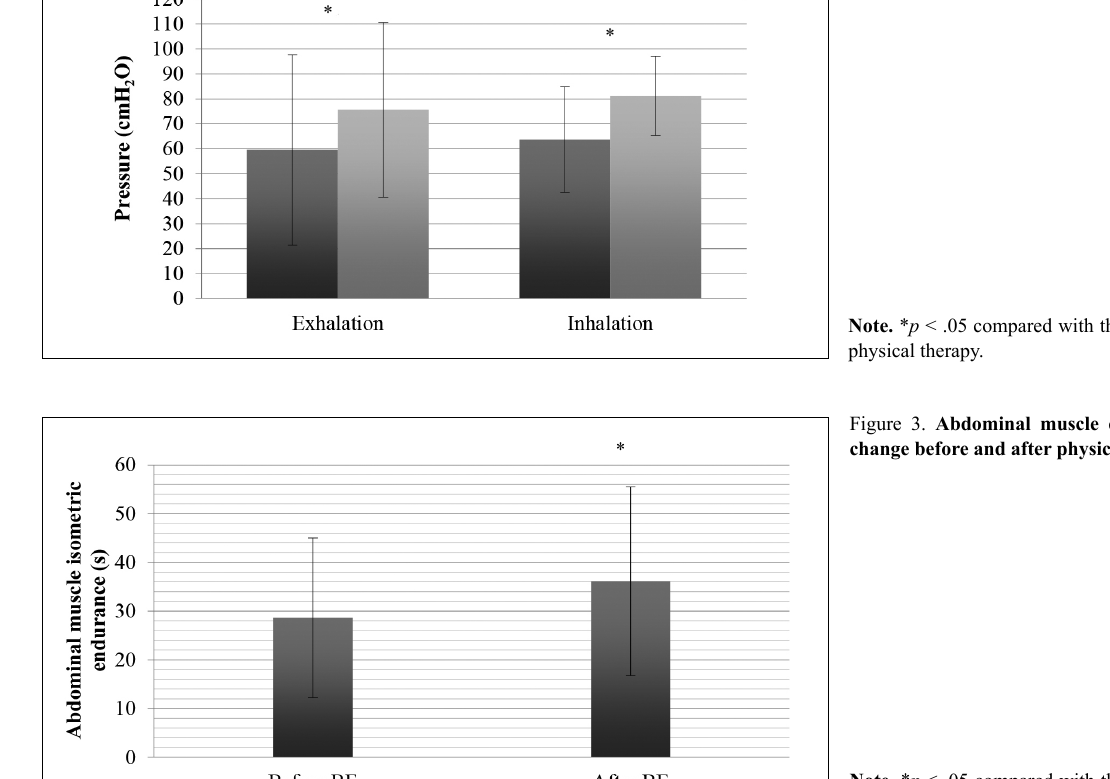
Note. * p < .05 compared with the result of physical